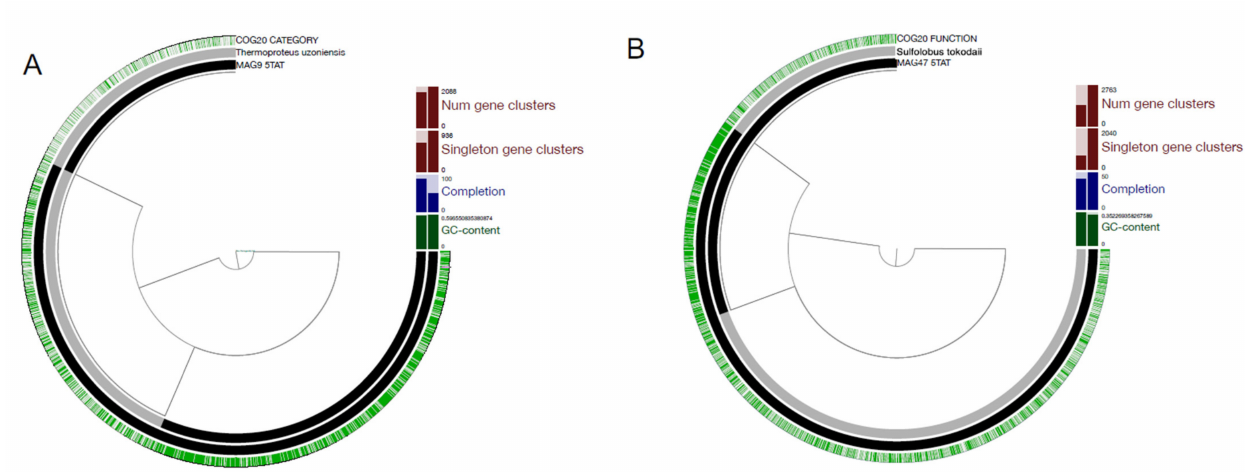
Figure 2. Pangenome analysis of MAG 9-5TAT ( A ) and MAG 47-5TAT ( B ) compared with their closest species produced in Anvi’o (Eren et al.,